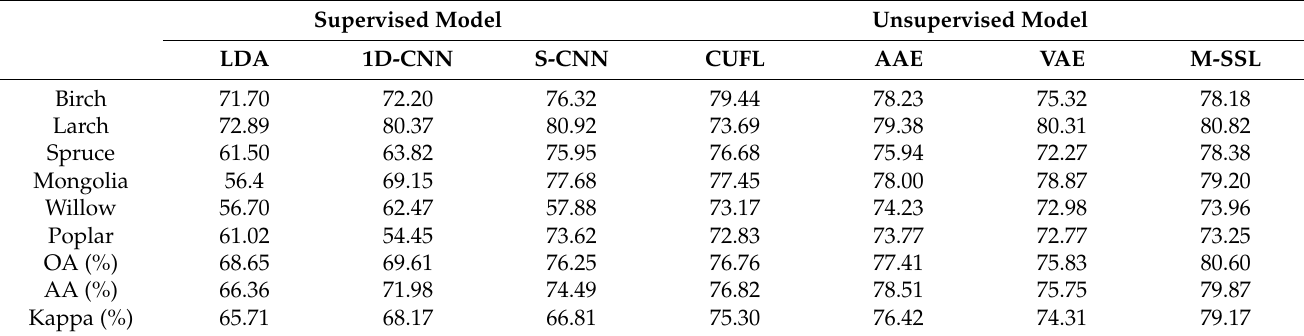
Table 11. The classification accuracy of models for dataset (1).